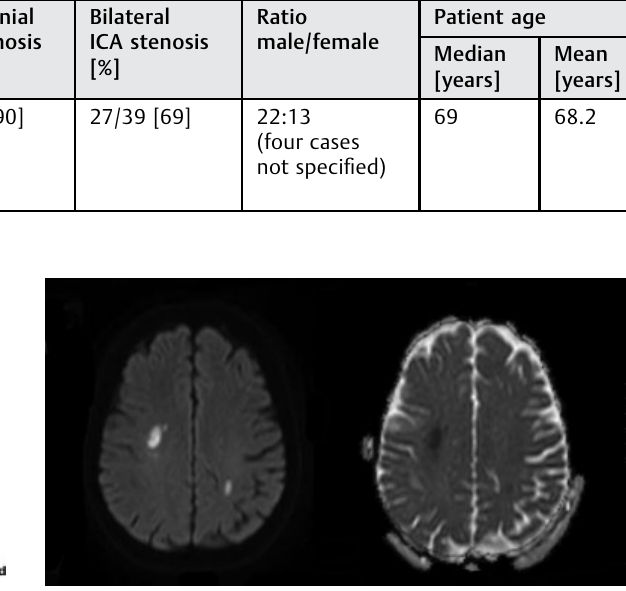
Fig. 2 MRI on the left side diffusion-weighted imaging (DWI), on the right side apparent diffusion coef fi cient (ADC) showing bilateral infarcts at the time of the initial hospital